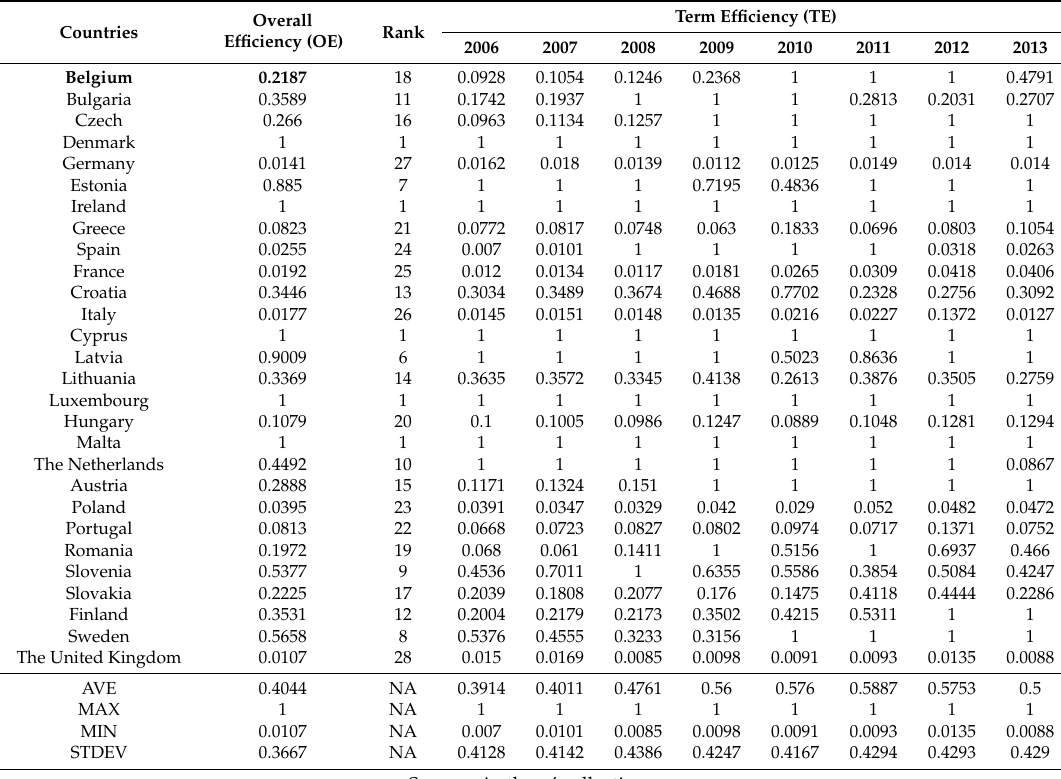
Table 6. Energy environmental efficiency of EU countries for 2006–2013. Overall Countries Efficiency